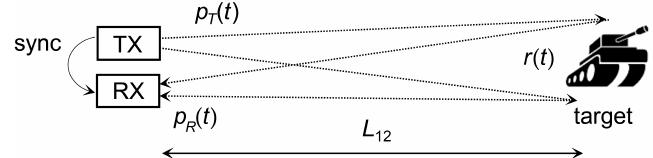
Figure 7. Rangefinder with a complex